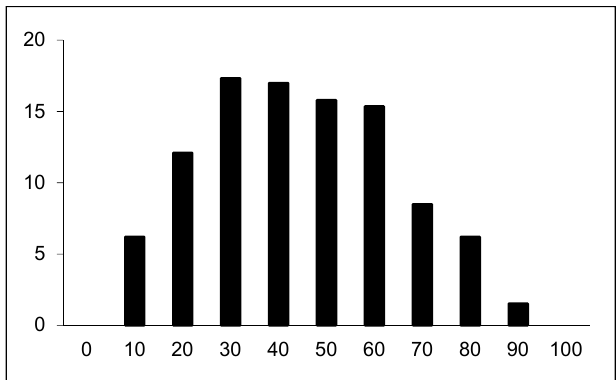
Figure 8 : Student performance in functions in Semester Test 1